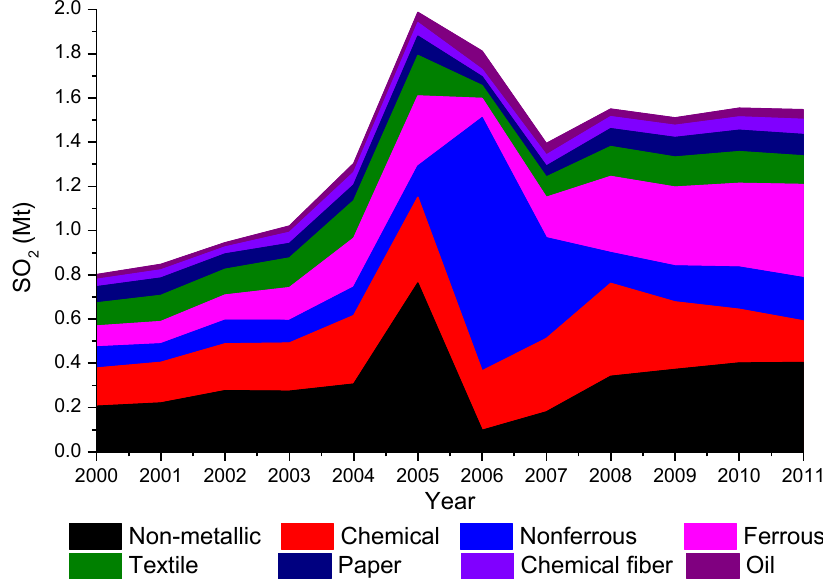
Figure 3. Temporal variations of SO 2 emissions of different manufacturing sectors in Jiangsu province during 2000–2011.